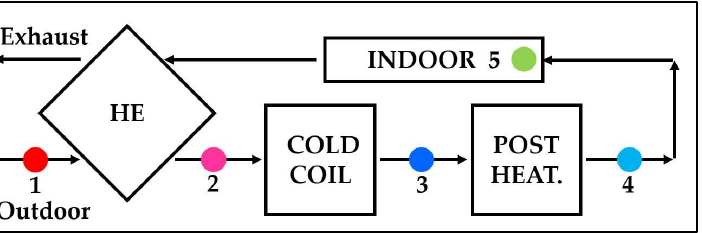
Figure 2. Schematic representation of a HVAC system with traditional dehumidification. A generic complete process is represented in Figure 3.